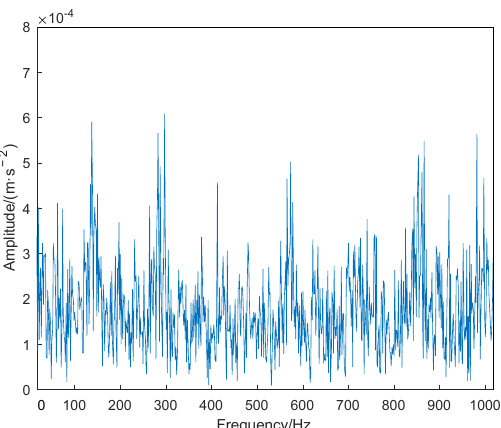
Figure 11. The envelope spectrum after modifying the parameters for MCKD processing.